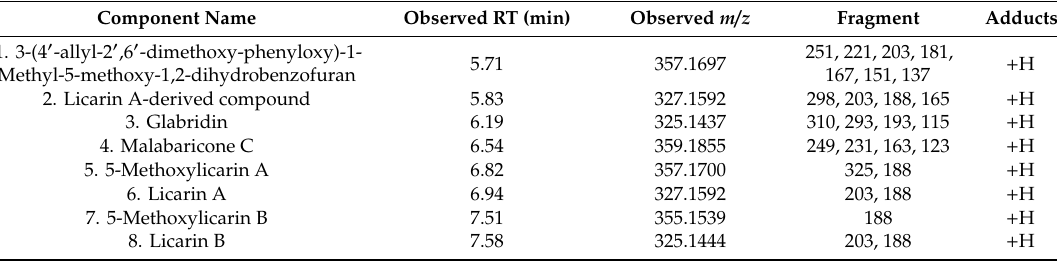
Table 1. List of chemical compounds identified from UPLC-MS / MS results of nutmeg